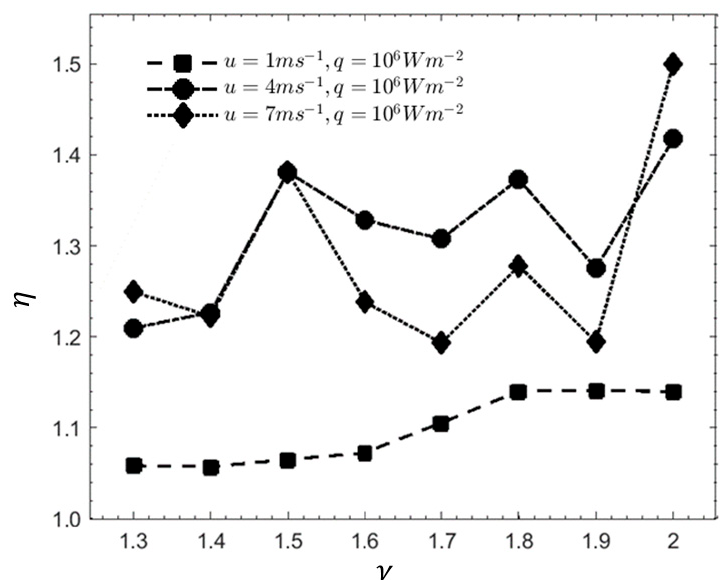
Figure 7. Nu (cid:2913)(cid:2929) /Nu (cid:2913)(cid:2928) against 𝛾 .